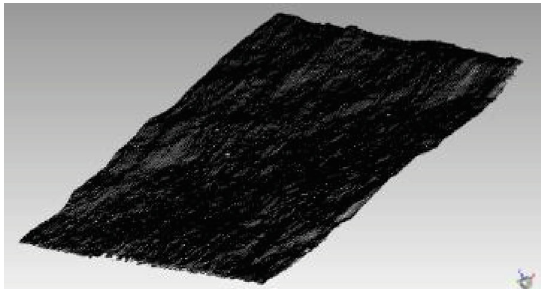
Figure 3: 3D morphological data of discontinuities.